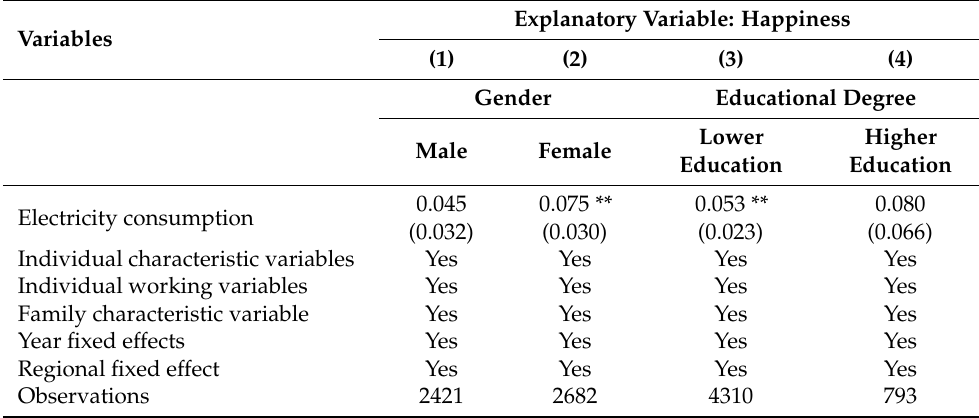
Table 6. Heterogeneity analysis from the perspectives of gender and education